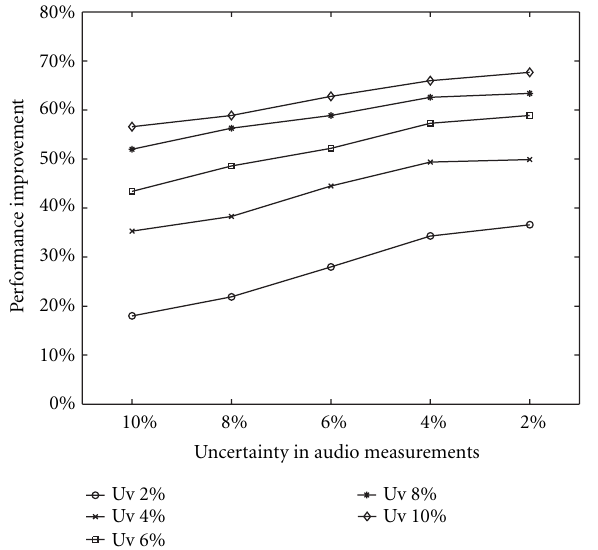
Figure 4: Plot of the percentage improvement in the performance of audio-video tracker versus the performance of video-only tracker for di ff erent combinations of audio and video measurement uncer- tainty.